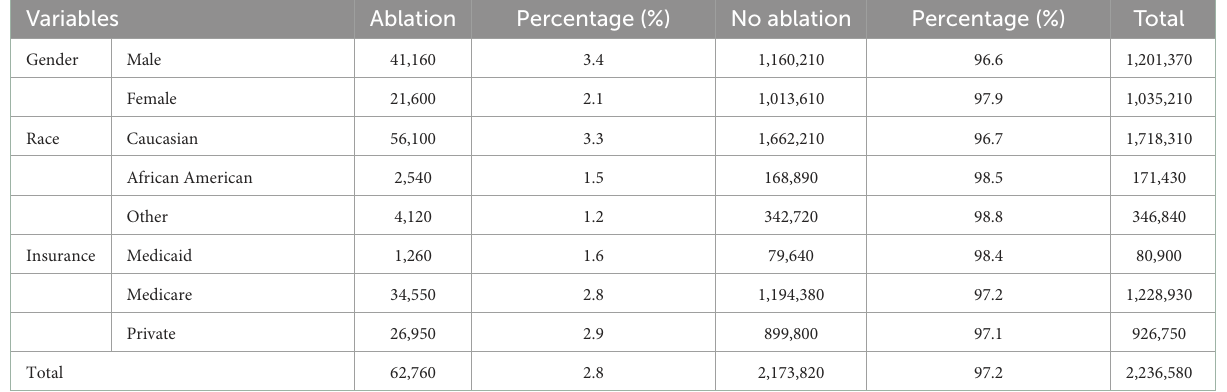
TABLE 2 Demographic distribution of all patients with atrial fibrillation who have undergone catheter ablation.